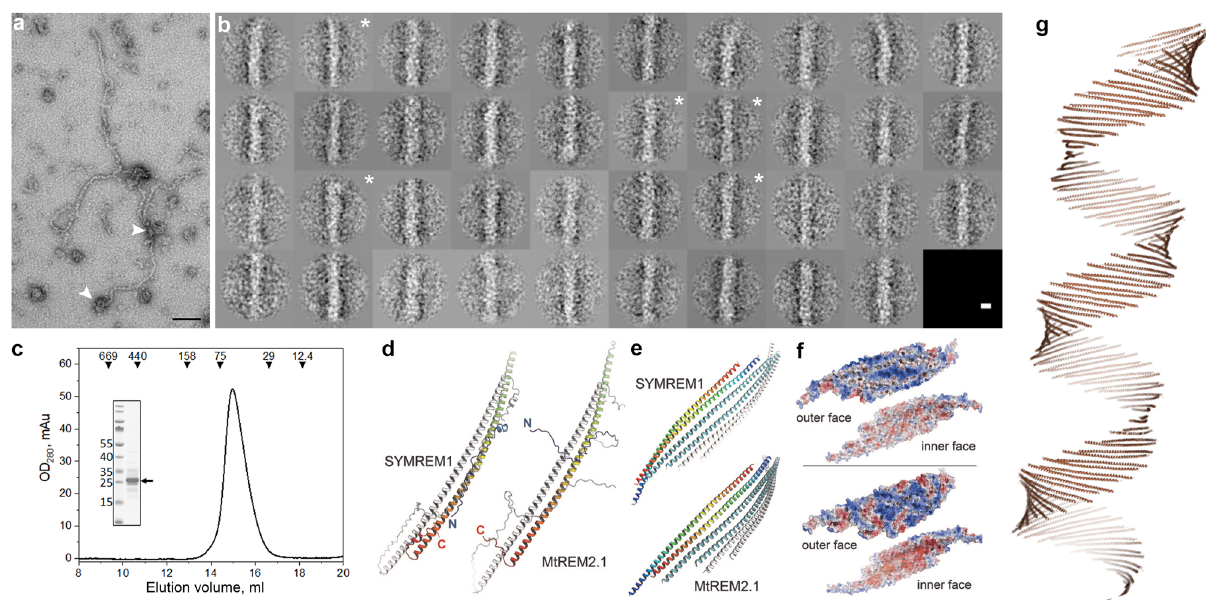
Fig. 2 | SYMREM1 forms oligomeric alpha helical assemblies. a Representative rawelectronmicrographofpuri fi ed,recombinantSYMREM1stainedwith2%uranyl acetate. Arrowheads indicate irregular protein bodies. Scale bar indicates 100nm, experiments were performed twice with independently isolated recombinant SYMREM1protein. b 2Dclassaveragesderivedfrommultivariatestatisticalanalysis ofall389particleimages.Eachclasscontainsonaveragetenimages.Classaverages that show twisted features are marked with a white asterisk. Scale bar indicates 100Å. c Elution pro fi le of recombinant His-SYMREM1. Molecular masses (in kDa) andpositionsofelutionpeaksforstandardproteinsareindicatedwithtriangleson the top. Insert: SDS-PAGE after Coomassie staining of the puri fi ed His-SYMREM1 (labeled by an arrow); molecular masses of the pre-stained protein standards are indicatedon the left inkDa. d AlphaFoldpredictions for homodimersofSYMREM1